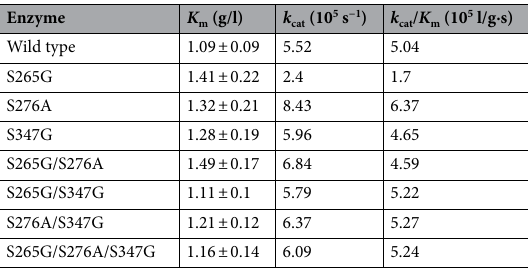
Table 3. Kinetic parameters of wild-type and mutated csnTS.